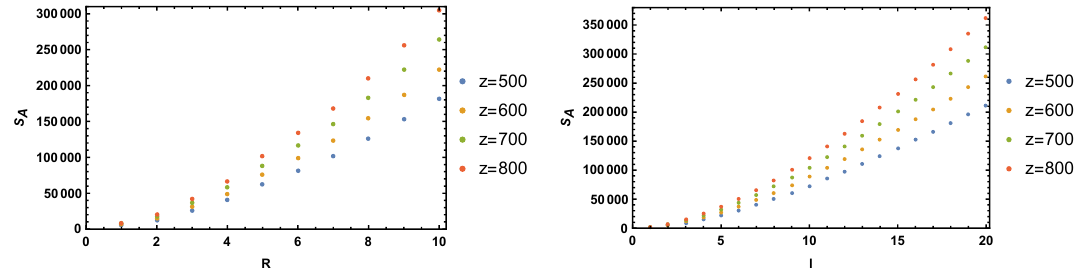
Figure 10 . Volume law for EE of a disk (with radius R ) is shown in the left panel and a square (with side ‘ ) in the right panel in the large z regime. We have set N x = N y = 250 and m = 0 with Dirichlet boundary